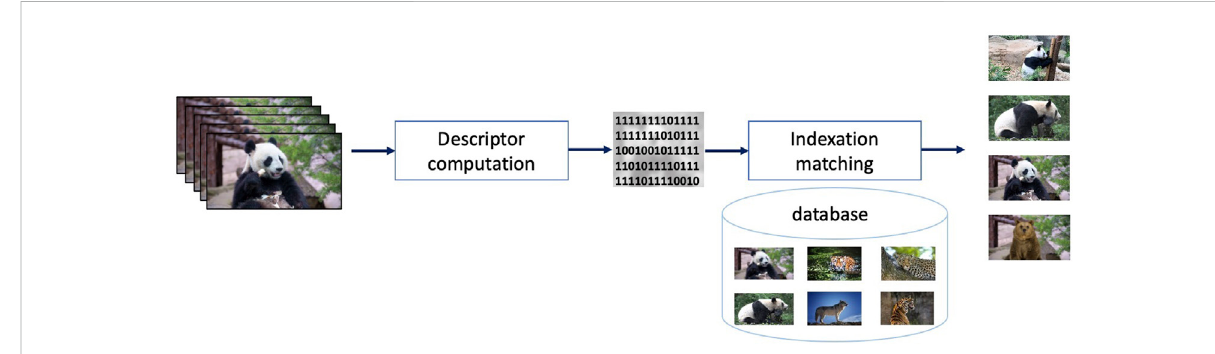
Figure 3. For instance, assuming again a video sequence representing some Panda bears is displayed on a screen and